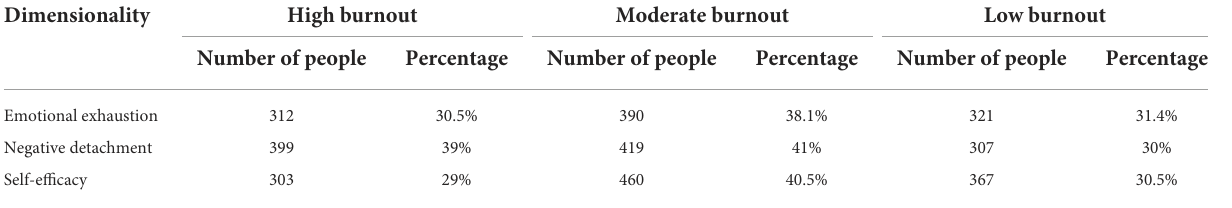
TABLE 4 Number of highly job burnout in various